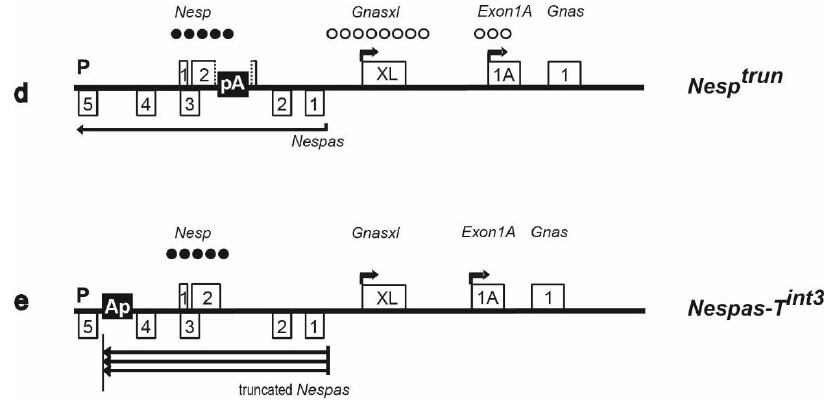
Figure 7. Summary of the transcriptional and methylation status of the paternal allele of the imprinted Gnas cluster in wild-type and mutant mice. ( a ) wild-type; ( b ) +/ Nespas-T ex1 ; ( c ) +/ Nespas-T int2 ; ( d ) +/ Nesp trun ; ( e ) +/ Nespas-T int3 . The Ap insertion truncates Nespas and the pA insertion will truncate Nesp if expressed. The approximate positions of the differentially methylated regions (DMRs) are shown by rows of filled circles on the methylated allele and unfilled circles on the unmethylated allele. Arrows show the start and direction of transcription, with thin arrows indicating weak transcription. Multiple arrows in ( c ) and ( e ) show increased levels of truncated Nespas . Exons 2–12 of Gnas are not